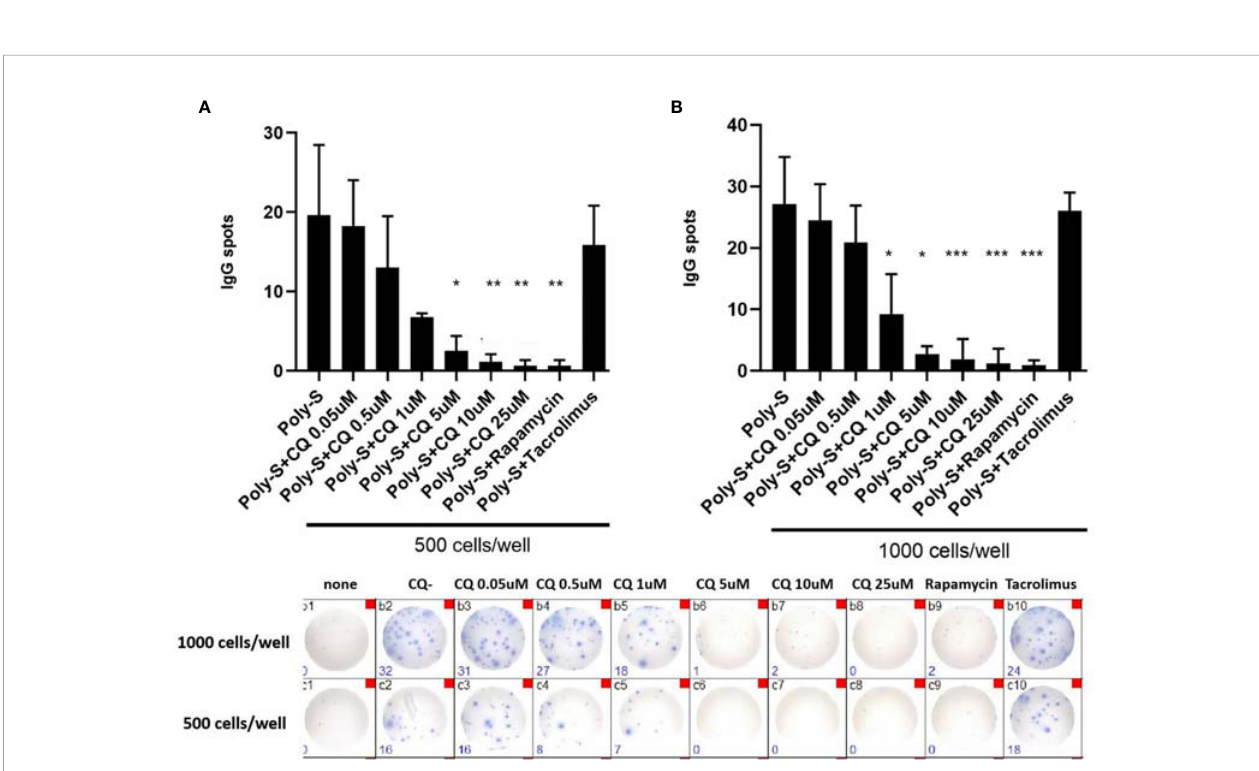
FIGURE 6 | Chloroquine suppresses antibody-synthesis by plasma cells. To assess if CQ has impact on antibody-secretion by B-cells, a human IgG-speci fi c ELISpot analysis was performed. Isolated CD19 + B cells were initially seeded at 5×10 4 cells/well under Poly-S stimulation in presence of CQ at different concentrations for four days. Then, cells were harvested and transferred to ELISpot plates at a density of 500 cells/well or 1000 cells/well to be cultured for another 24 hours. (A, B) Impact of CQ on IgG-secretion of plasma cells using puri fi ed B cells. P-values were calculated by repeated-measures ANOVA and correction for multiple comparisons were done by Dunnett ’ s test. *p < 0.05, **p < 0.001, ***p < 0.0001 (against Poly-S as control